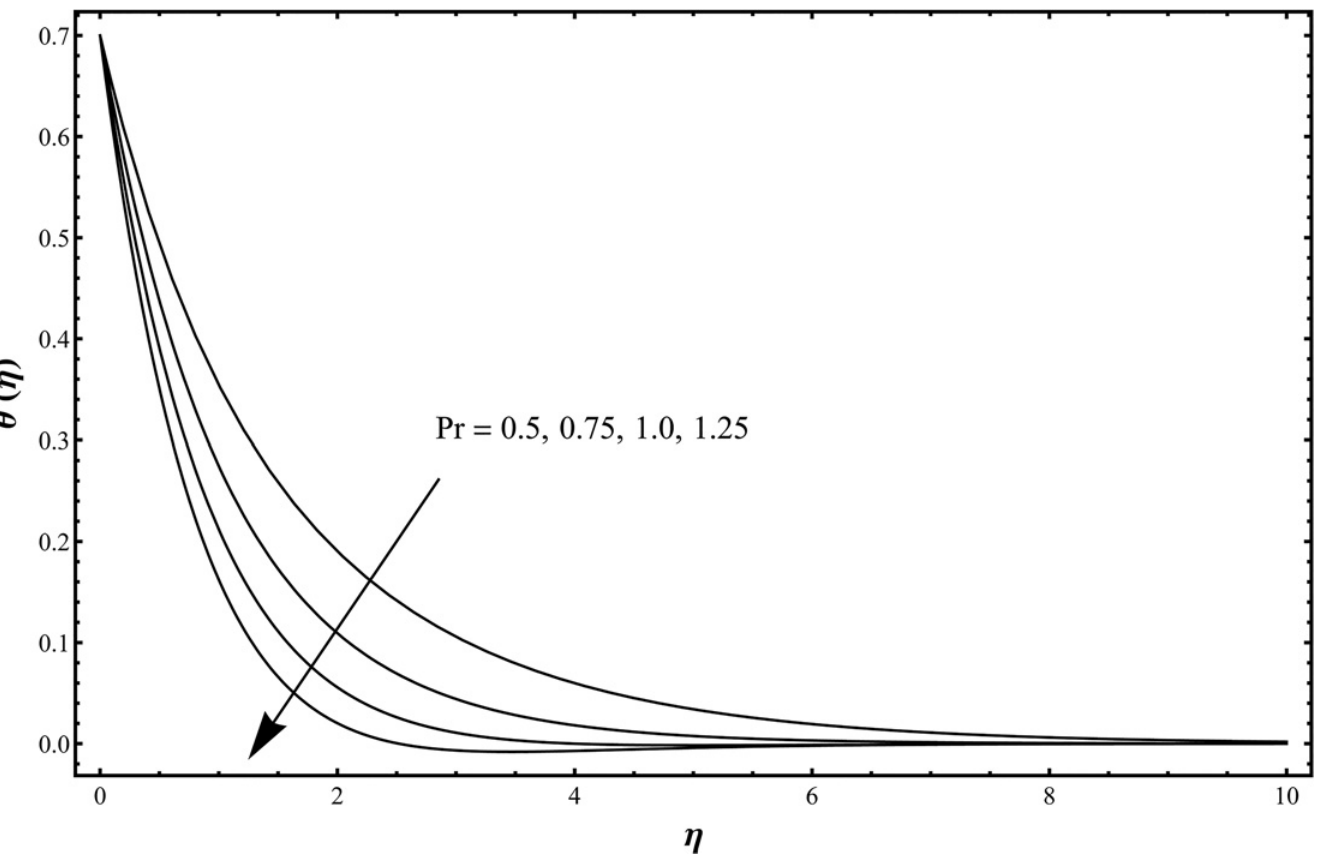
Fig 6. Temperature distribution function θ ( η ) when Pr = 0.5, 0.75, 1.0, 1.25 and β 1 = β 2 = 0.2 = γ = Rd , λ = 0.1 = N , Sc = 1.0, ε 1 = 0.3 = ε 2